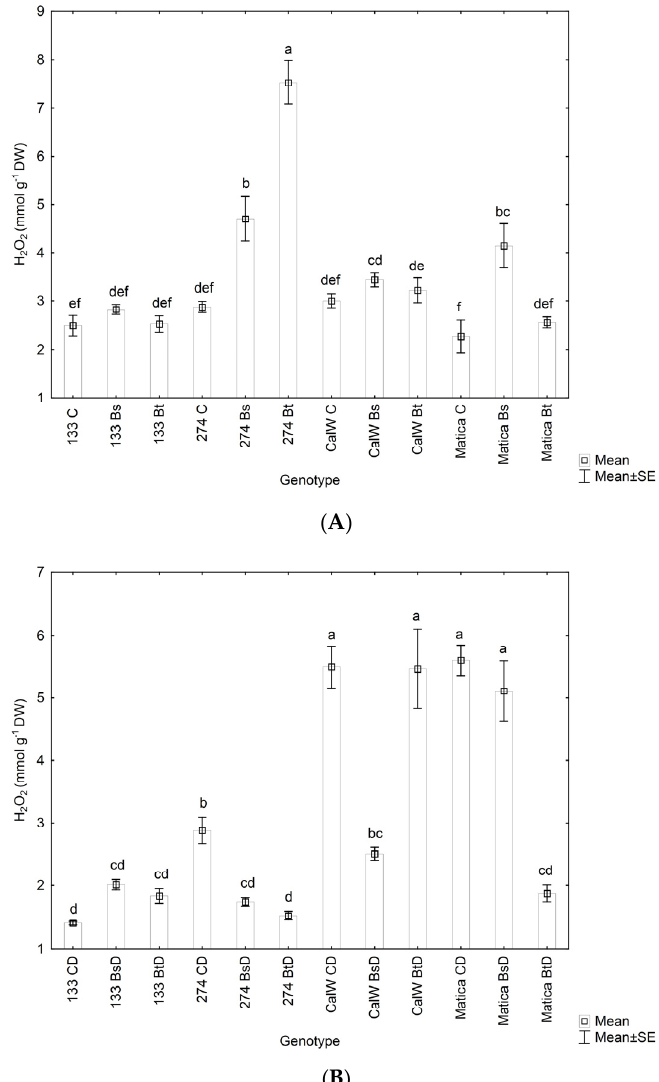
Figure 3. H 2 O 2 content in leaves of 133, 274, CalW, and Matica genotypes in ( A ) control (C) and ( B ) drought (D) conditions treated with two bacterial strains, B. safensis SS-2.7—Bs and B. thuringiensis SS-29.2—Bt. Different letters show significant differences between genotypes ( p < 0.05) according to Duncan’s test.